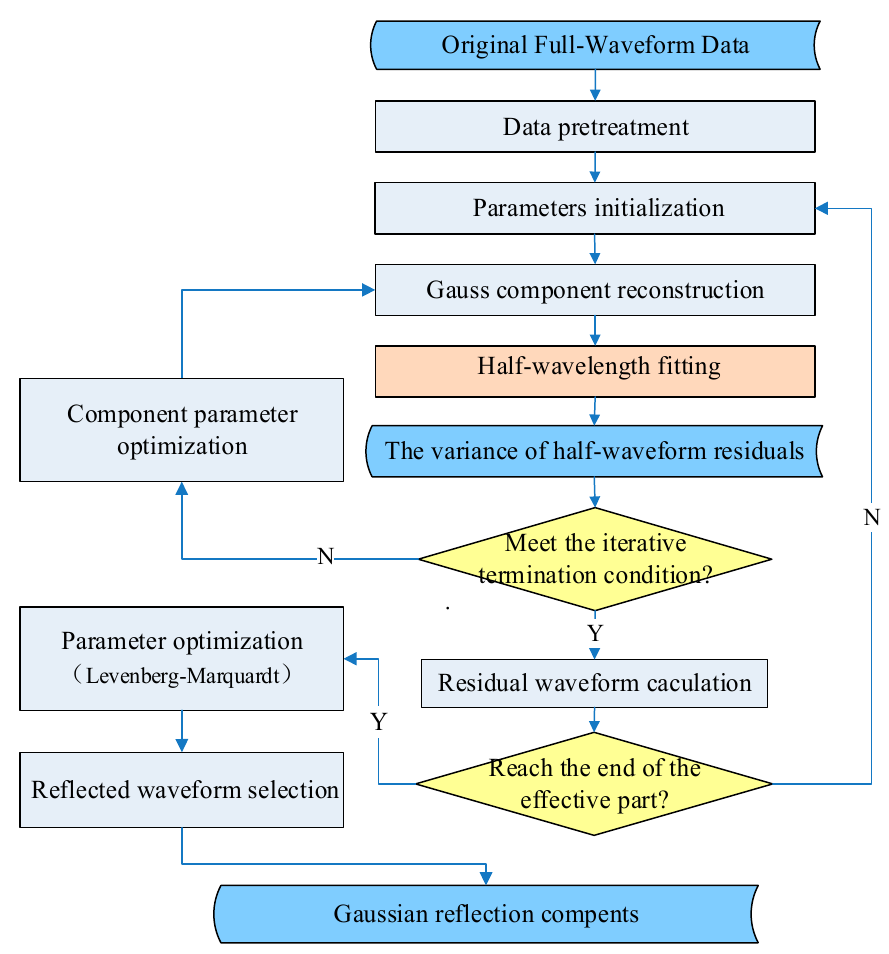
Figure 2. Working flow of the GHPD algorithm.